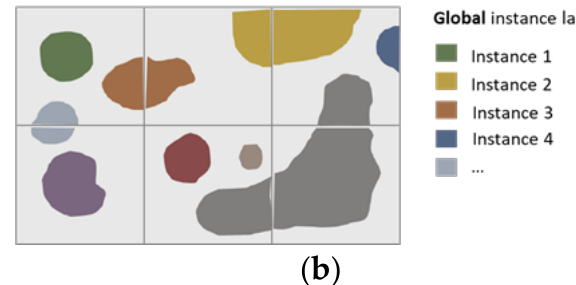
Figure 12. Local instance labels per tile ( a ) vs. global instance labels of merge result ( b ). The proposed approach addresses this problem by sliding the window in such a way that adjacent window positions overlap. The region where the two windows over- lap thus gets segmented twice. Instances predicted in the two positions (hereafter also referred t o as “tiles”) were then merged based on their spatial overlap in the “global” context of the large image. For each instance in “tile A”, the spatial overlap with each in- stance of “tile B” was computed. To quantify this overlap, the IoU score between the portion of instance n from Tile A that lies in the overlapping region and the portion of